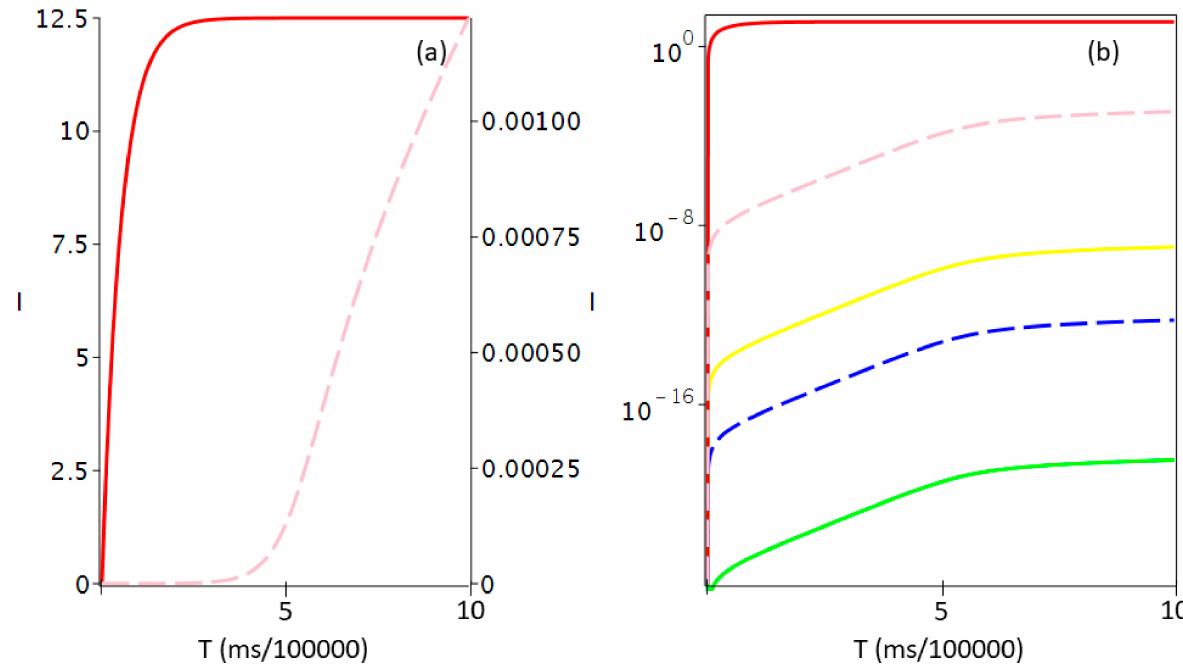
Figure 4. Abundance of selected species (in nm − 2 ) over time. ( a ) I 1 —red, left vertical axis and I 2 —pink-dashed, right vertical axis. ( b ) I 1 —red, I 2 —pink-dashed, I 3 —yellow, I 4 —green and I 5 —blue-dashed (log scale). Note that steady-state flow is not achieved until ~600